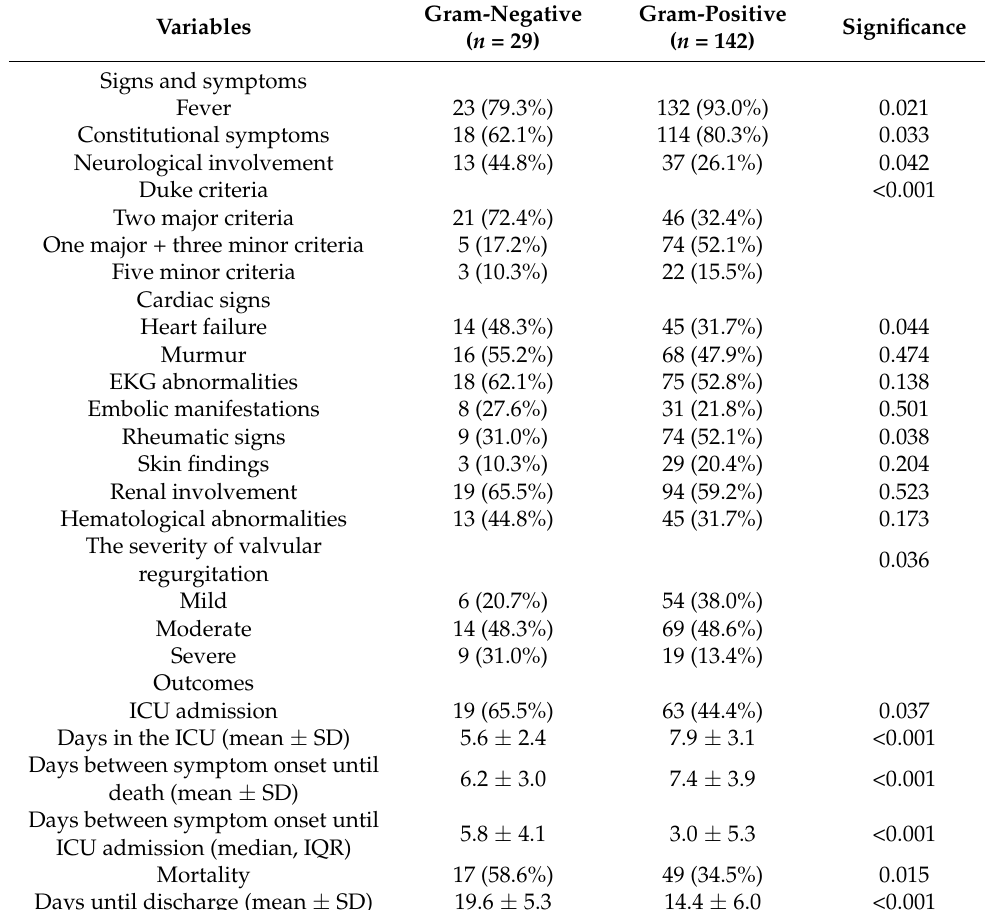
Table 3. Clinical findings and outcomes of patients with Gram-negative and Gram-positive